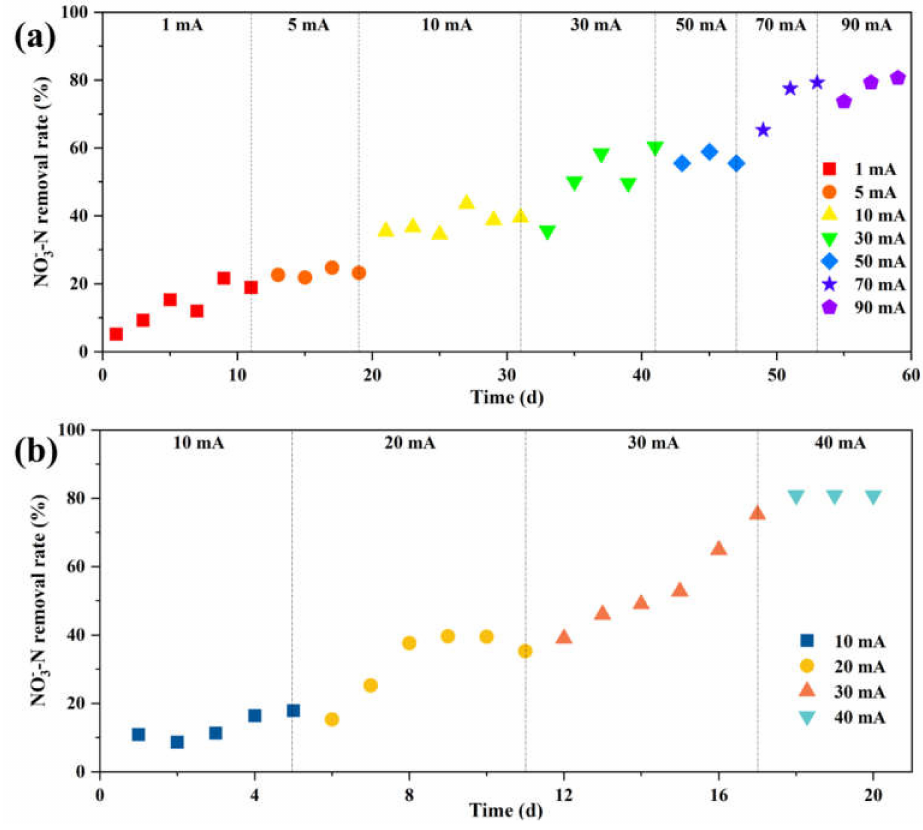
Figure 2. Nitrate removal rate during the start-up of ( a ) EHD; ( b ) SHD −